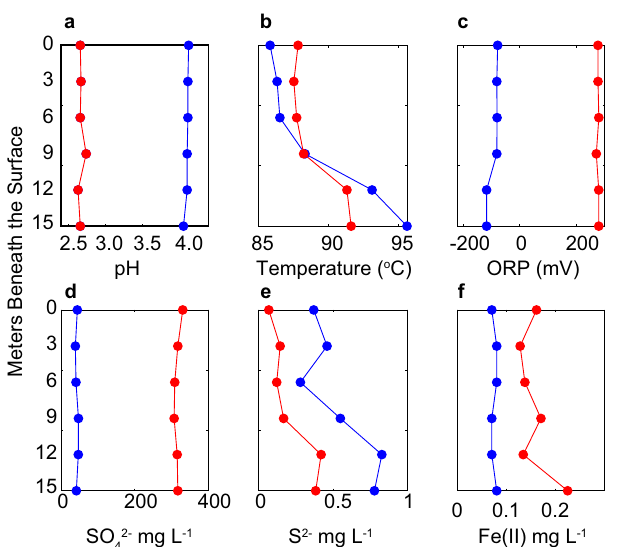
Fig. 2 Depth-resolved geochemical measurements for Cinder Pool (CP) waters collected in 2016 and 2020. Measurements of a temperature, b pH, c oxidation – reduction potential (ORP), d SO 4 2 − , e total sul fi de (S 2 − ), and f Fe(II) were taken from waters pumped from 0, 3, 6, 9, 12, and 15 m depth or using an in situ thermocouple (temperature only). Blue circles show measurements taken in 2016 and red circles show measurements taken in